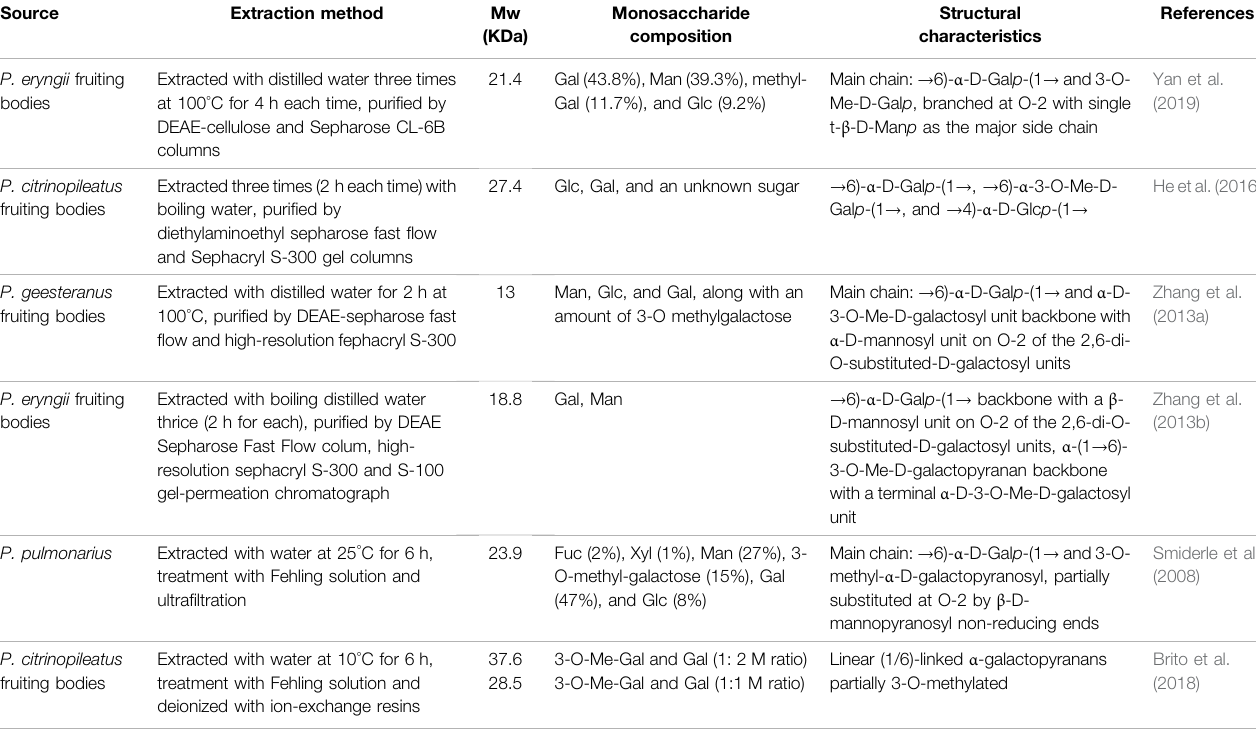
TABLE 4 | A summary of 3- O -Me- D -Gal p polysaccharides from Pleurotus spp. Source